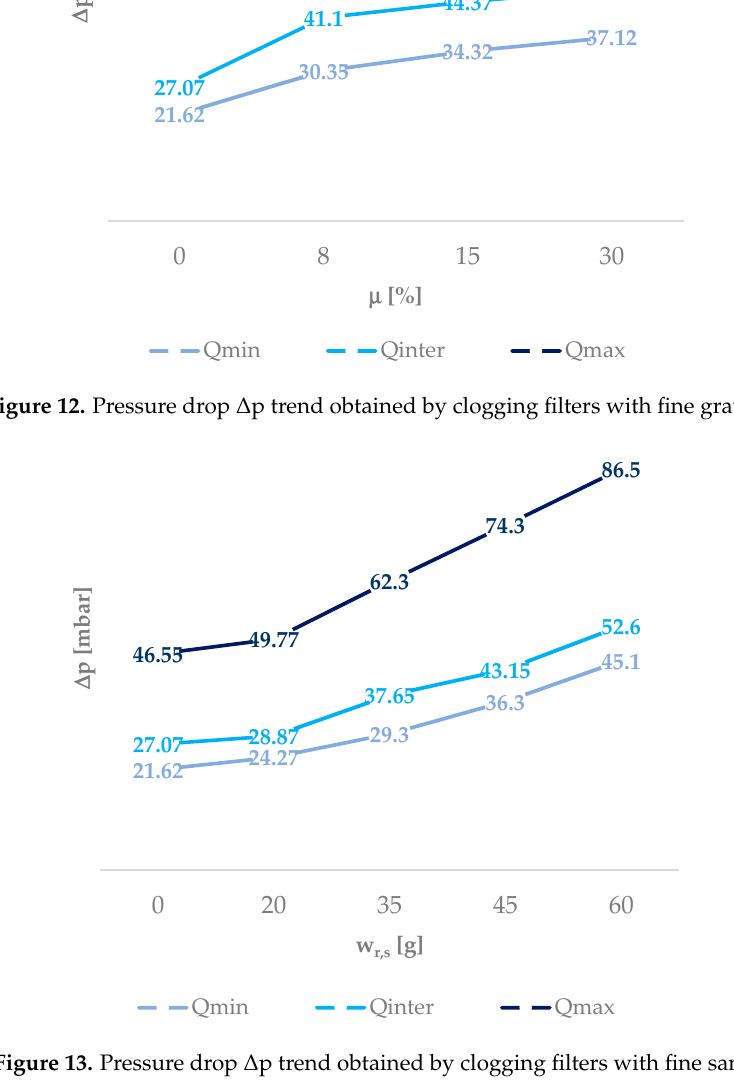
Figure 13. Pressure drop ∆ p trend obtained by clogging filters with fine sand.